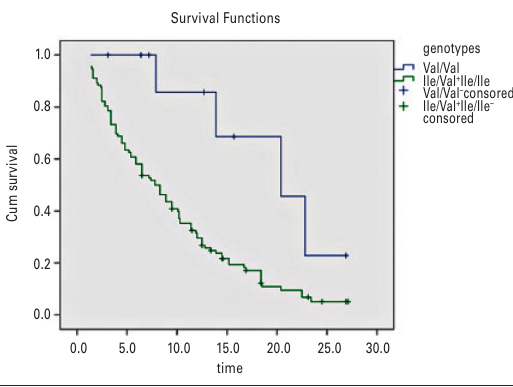
Association between GSTP1-105 genotypes (Ile/Ile and Ile/Val as a combined group) and overall survival in pa- tients with metastatic colorectal cancer receiving 5-fluo- rouracil/oxaliplatin chemotherapy.The vertical hash marks denote the time of last follow-up for those patients who were still alive at the time of the analysis of the